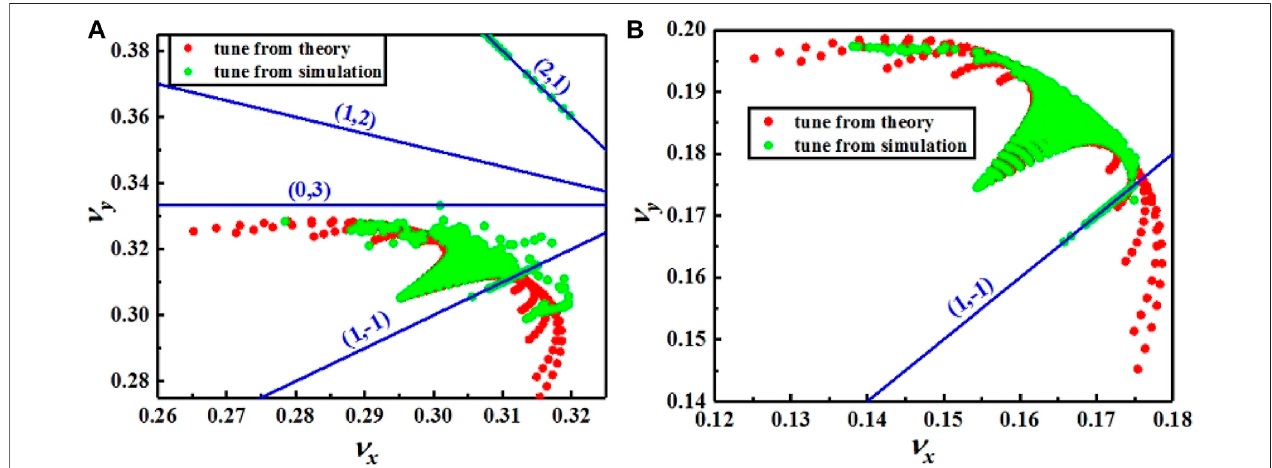
FIGURE 3 | Footprint by the beam-beam interactions for different initial nominal tunes: (A) (0.31, 0.32) and (B) (0.17, 0.19). Red and green points are from the theoretical calculation and the simulations, respectively. The lines show all nearby resonances up to the fourth order. The numbers ( m , n ) in brackets de fi ne resonances m ] x + n ] y = p , where p is an integer.